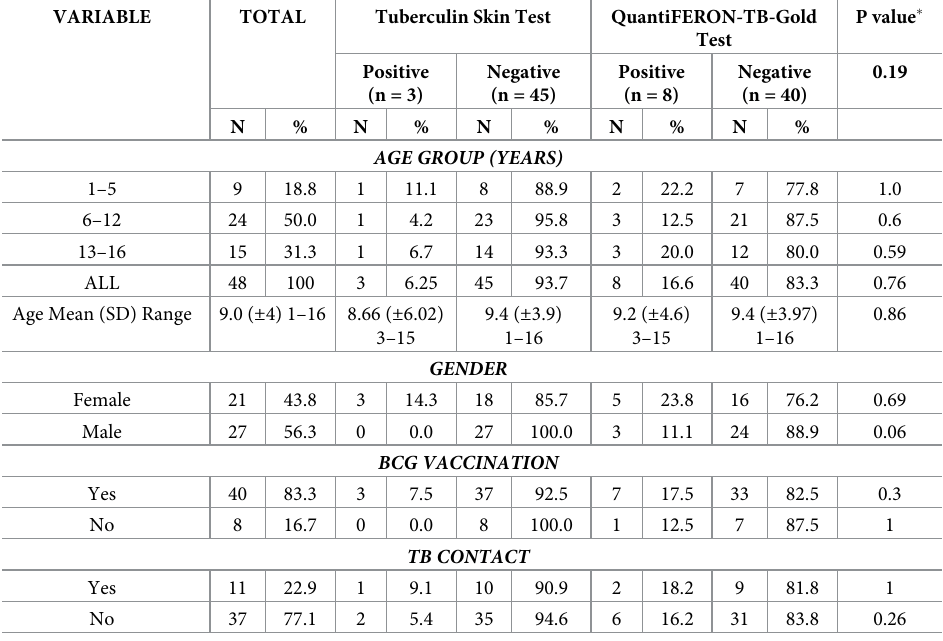
� comparison test of measures between positive cases according to the test used for the total and sub-categories.